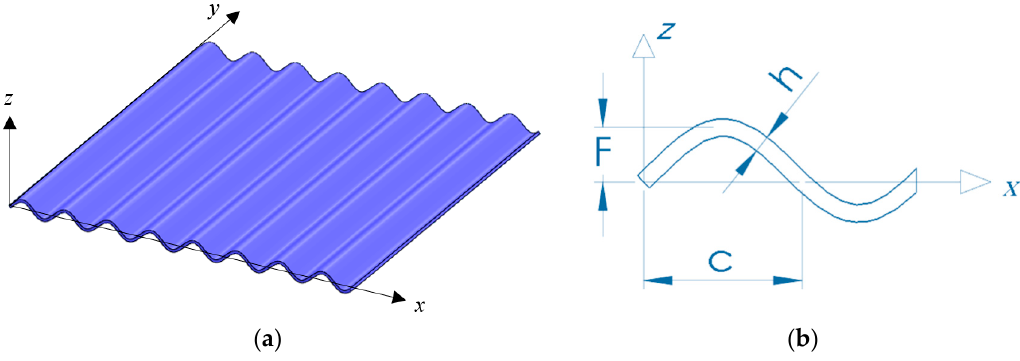
Figure 1. Corrugated nanoplate: ( a ) 3D view, and ( b ) in-plane geometry.